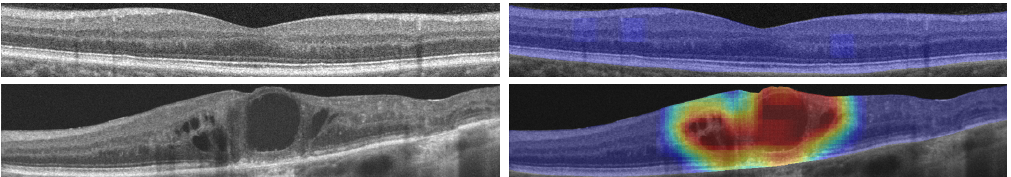
Figure 2. Results from a Cirrus HD-OCT OCT device from Carl Zeiss Meditec, including a healthy and a pathological